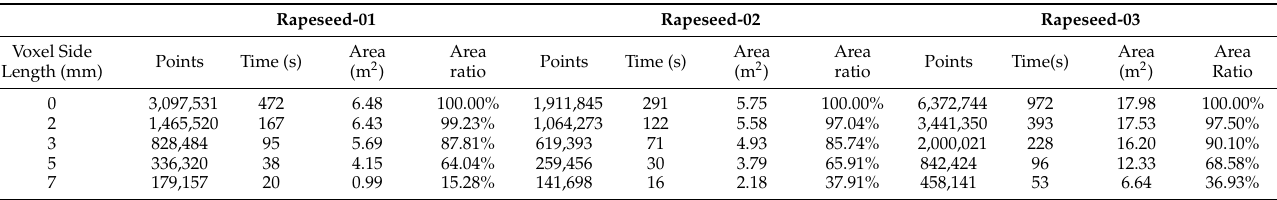
Table 4. Output parameters of field rapeseed point cloud in LA-DT under different